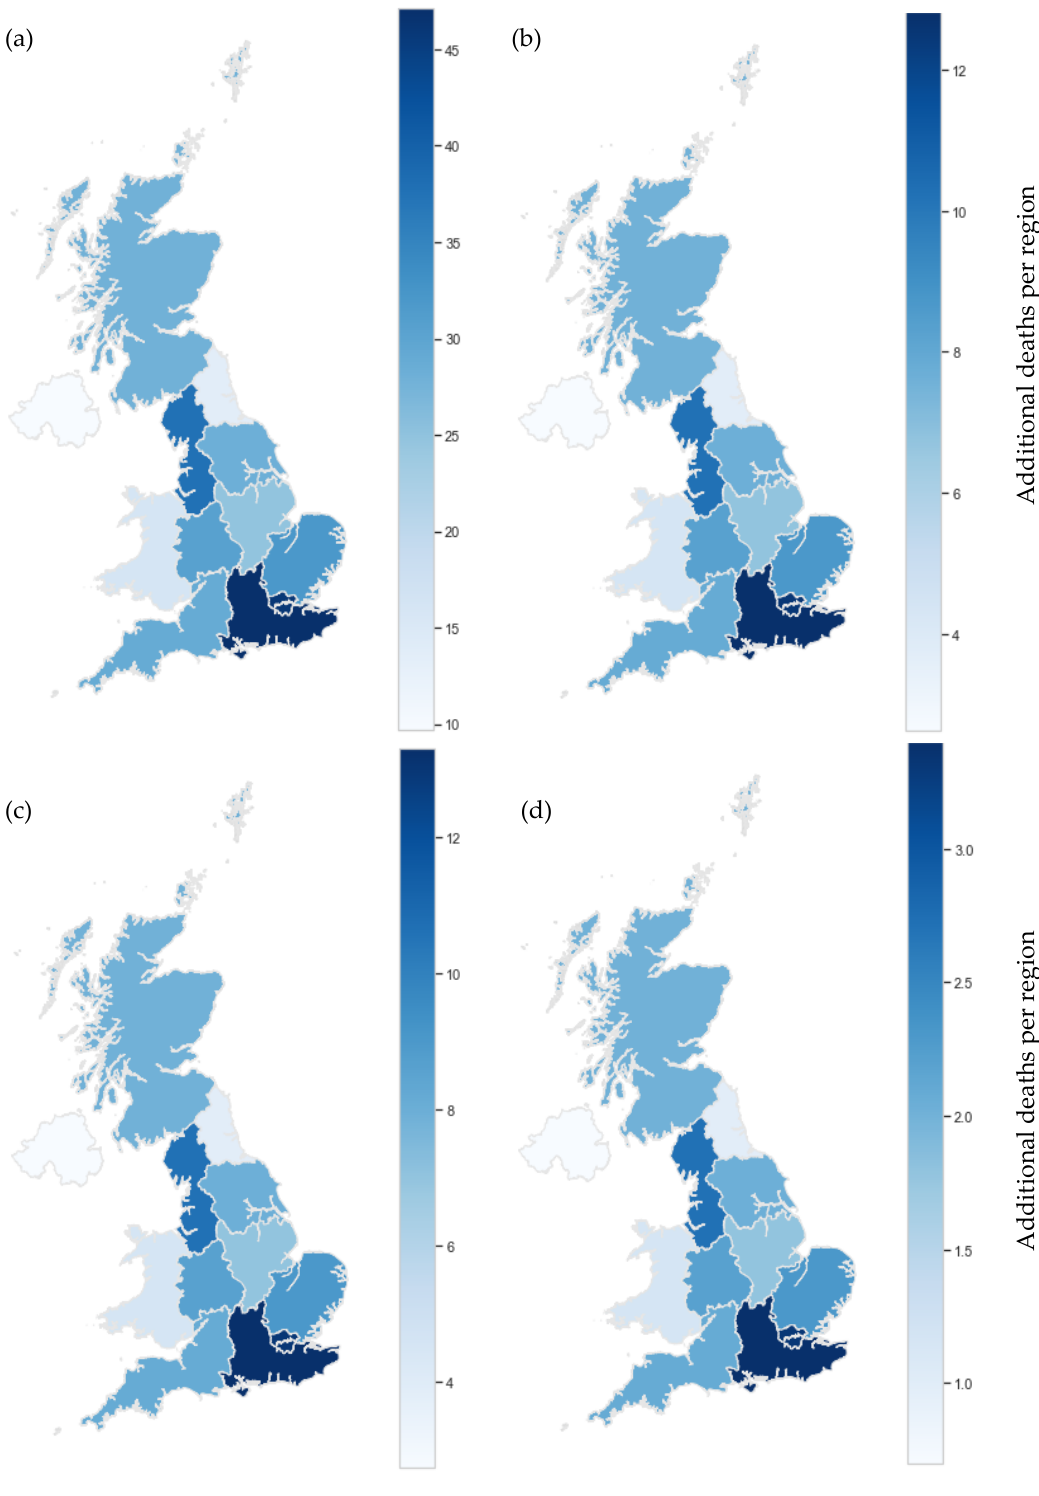
Figure 7. Upper and lower limits of average yearly cancer impact from benzene and 1,3-butadiene for 2020. ( a ) Benzene urban, ( b ) Benzene rural, ( c ) 1,3-Butadiene urban, ( d ) 1,3-Butadiene rural. To represent the upper and lower limit cancer impact of benzene and 1,3-butadiene in the U.K., the average cancer impact at urban and rural sites was paired with population data obtained from the Office for National Statistics (ONS) [49] and plotted on a national